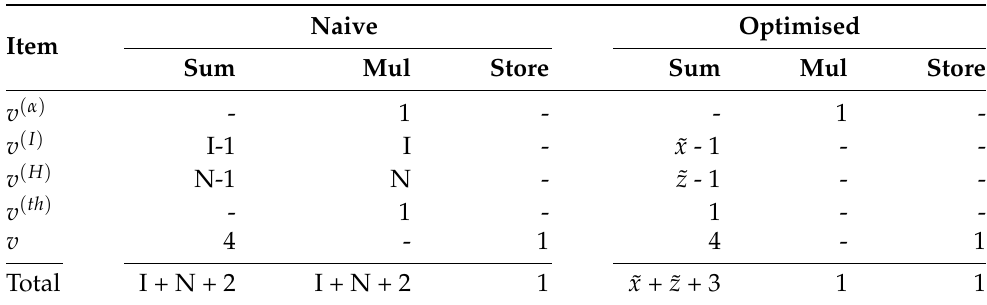
Table 2. Operations analysis for a single neuron. These operations must be executed for each neuron ( N ) and for each inference tick ( t inf